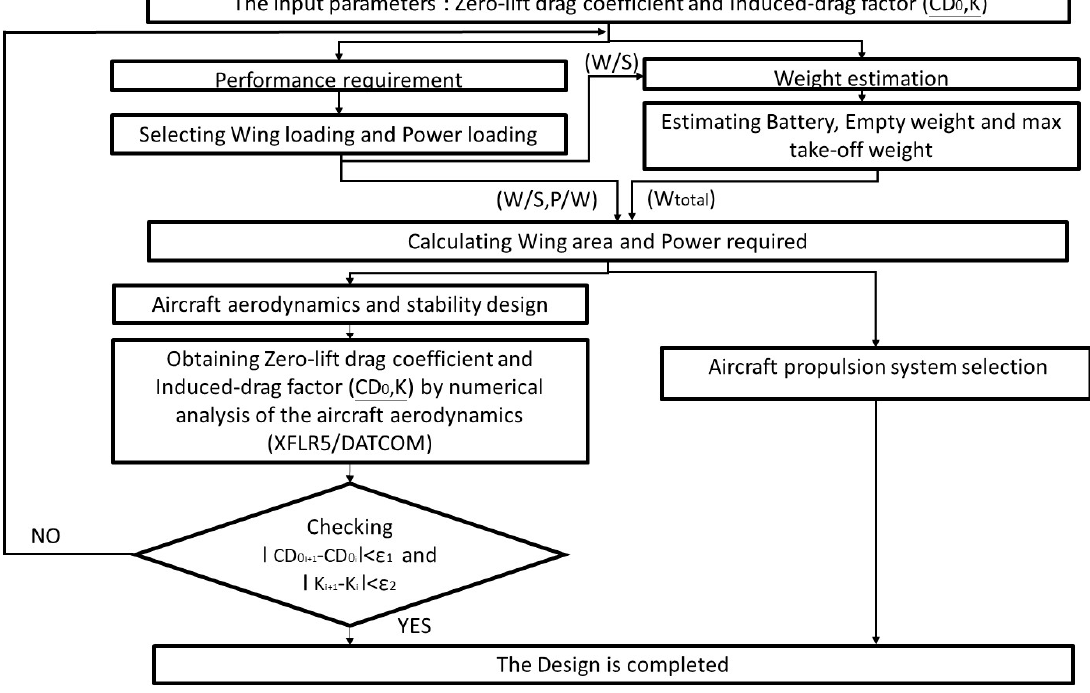
Figure 1. Design procedure for experimental flying wing unmanned aerial vehicle (UAV).